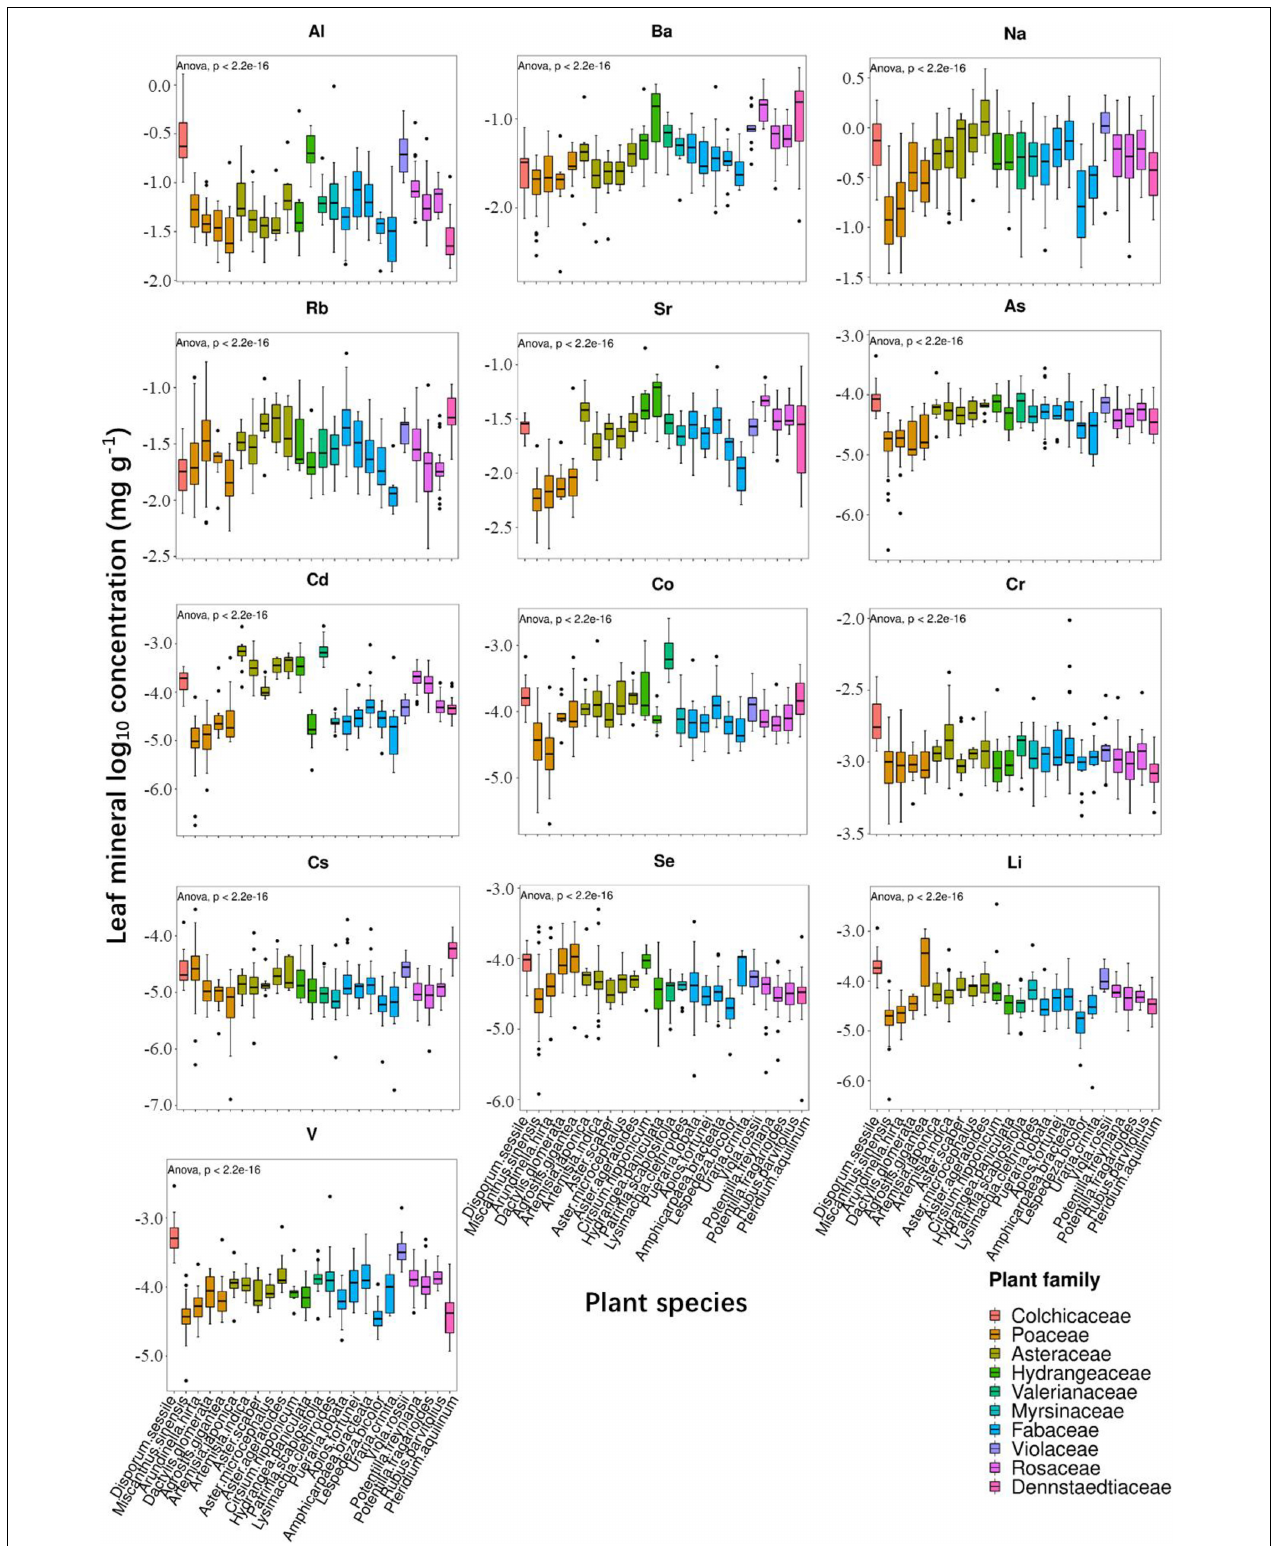
FIGURE 3 | Boxplot showing leaf log 10 concentrations of 13 non-essential elements (Al, Na, Ba, Rb, Sr, As, Cd, Co, Cr, Cs, Se, Li, and V) for 24 different plant species.